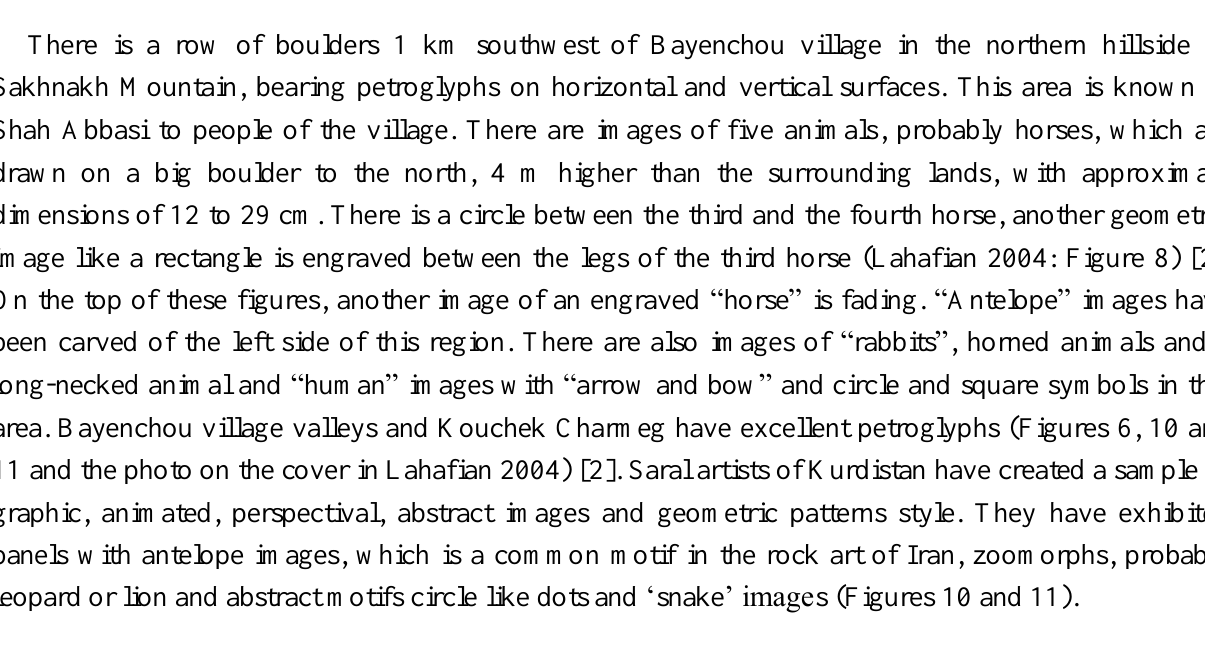
Figure 10. Saral, valleys of Kouchekcharmeg village on the vertical surface of a boulder, big spiral images, “antelope”, “deer”, and other